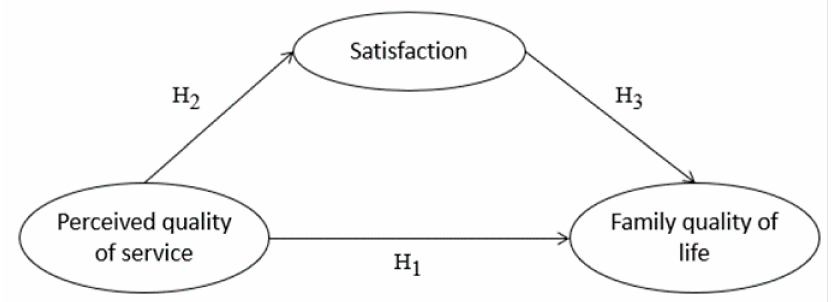
Figure 1. Proposed conceptual